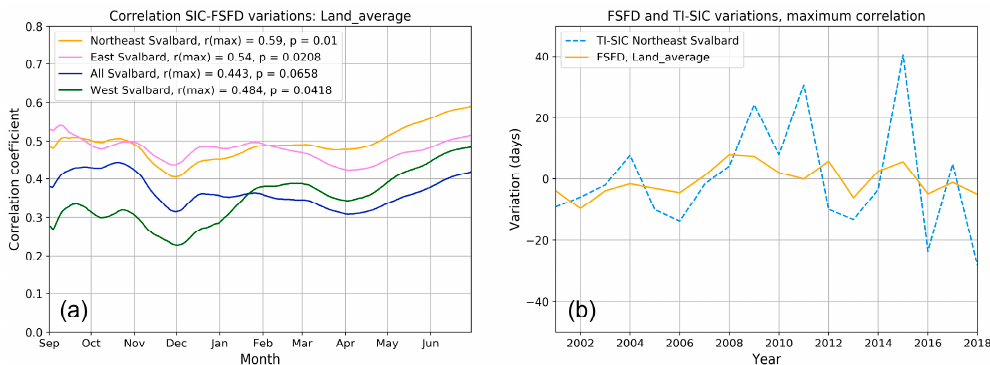
Northeast Svalbard.